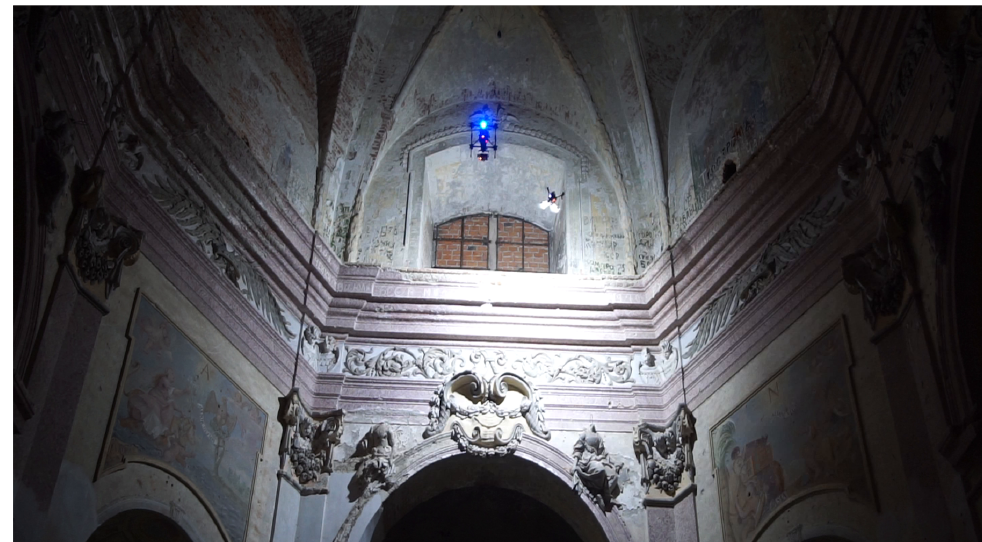
Figure 7. Applying Reflectance Transformation Imaging documentation technique in the Church in Stará Voda. The unmanned aerial vehicle carrying the camera (equipped with a blue indication diode) is hovering in front of the vault located approximately 12 m above the ground while the unmanned aerial vehicle equipped with light is flying through predefined positions to provide lighting from all-around directions.